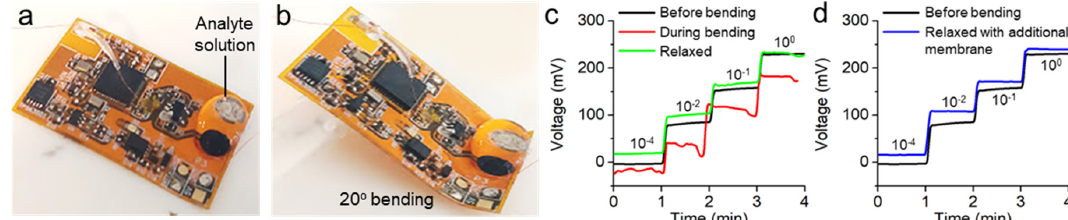
Figure 5. Wireless sodium detection with film ISEs. Photographs of circuit ( a ) before bending and ( b ) during 20° bending. ( c ) Voltage responses with different sodium concentrations for three cases: before bending (black line), during bending (red line), and after bending (green line). ( d ) Comparison of voltage responses, showing the role of additional polyvinyl butyral (PVB) membrane on RE. Table 2. Comparison of device materials, structure, and performance.